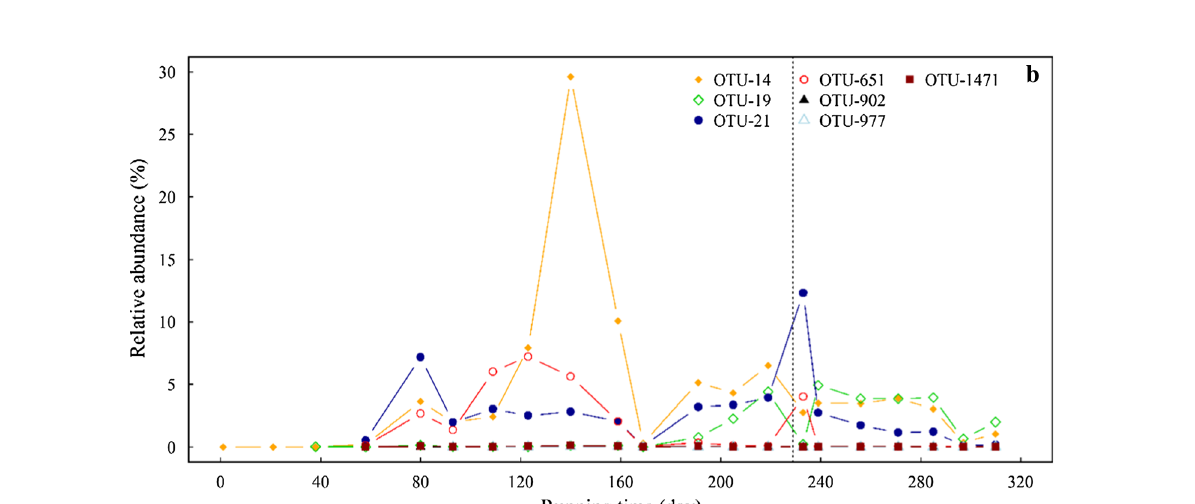
Fig. 6 a Neighbor‑joining tree of anammox bacterial OTUs, based on 16S rRNA gene fragments. Bootstrap values (> 50%) shown on branch nodes are based on 1000 trials. Bar: evolutionary distance 0.01. b Relative abundance of these OTUs during the entire running period. Dotted line as in Fig.